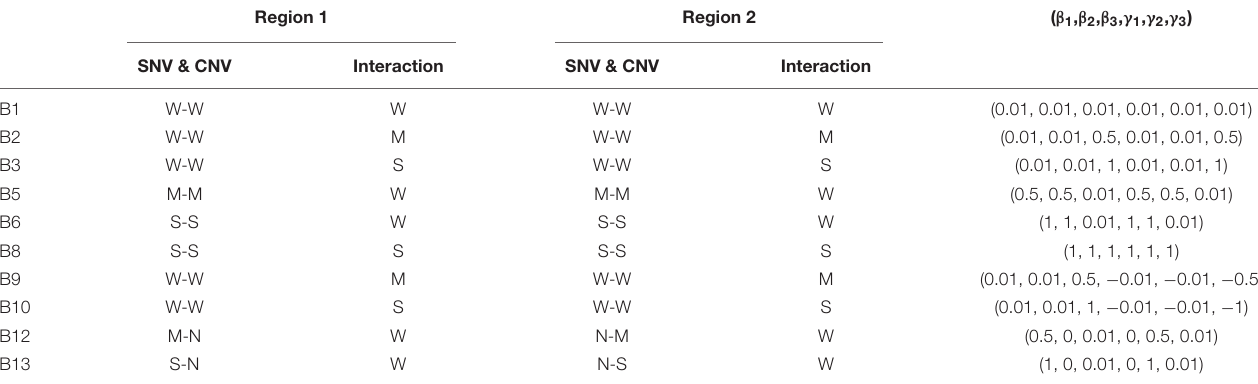
TABLE 3 | The list of selected settings and parameter values in simulation Part B, where W is for weak, M for moderate, S for strong, and N for no effect.